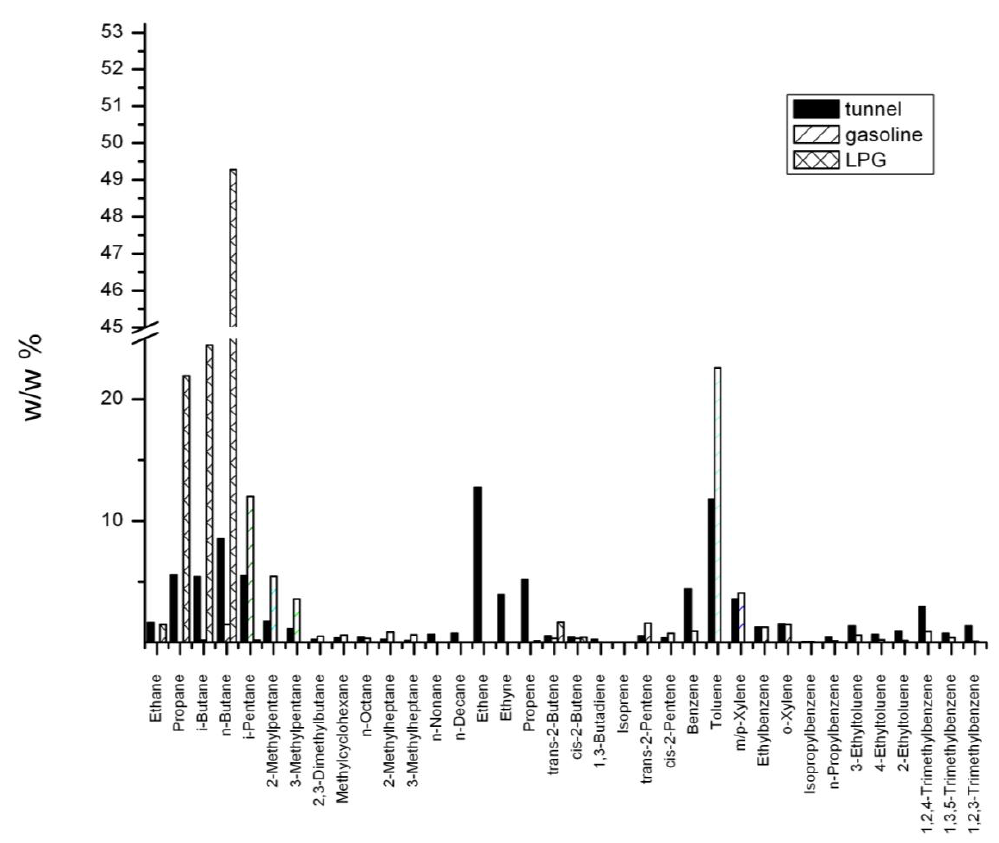
Fig. 2. Average VOC distributions (presented in w/w%) for gasoline vapor, LPG and Shing Mun Tunnel